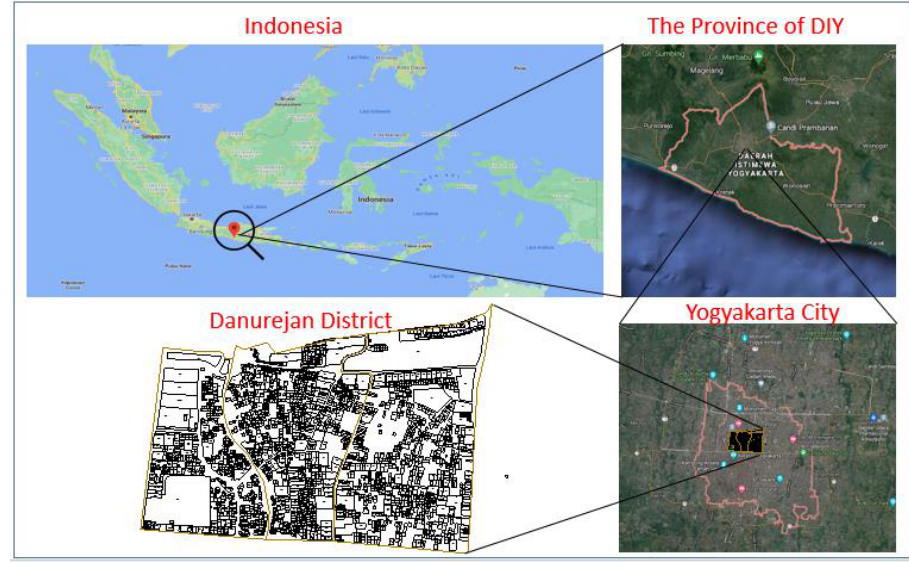
Figure 2. Location of the sample (Danurejan District, Yogyakarta City, Yogyakarta Special Province, Indonesia).